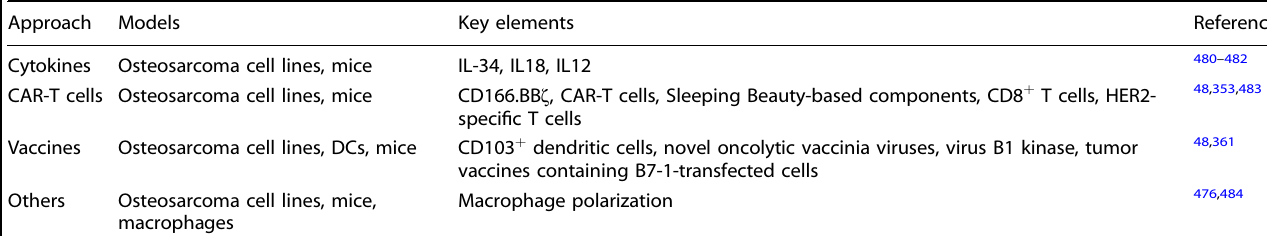
Table 3. Preclinical immunotherapies in osteosarcoma Approach